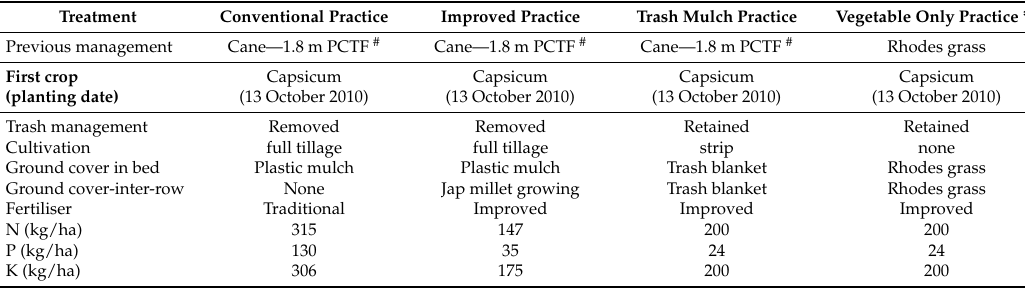
Figure 1. Field lay out of the experimental plot. The field was split into four management units with each unit being 280 m long and 9 m wide (i.e., 5 × 1.83 m cane rows), with contrasting management systems randomly allocated to each strip. The 280 m length was subdivided into two subunits of approximately 120 m and 160 m based on a highpoint in the middle of the field, with drainage in either direction in response to a 1% slope. HF indicates high fertiliser input treatments. Table 1. A comparative summary of treatment characteristics.